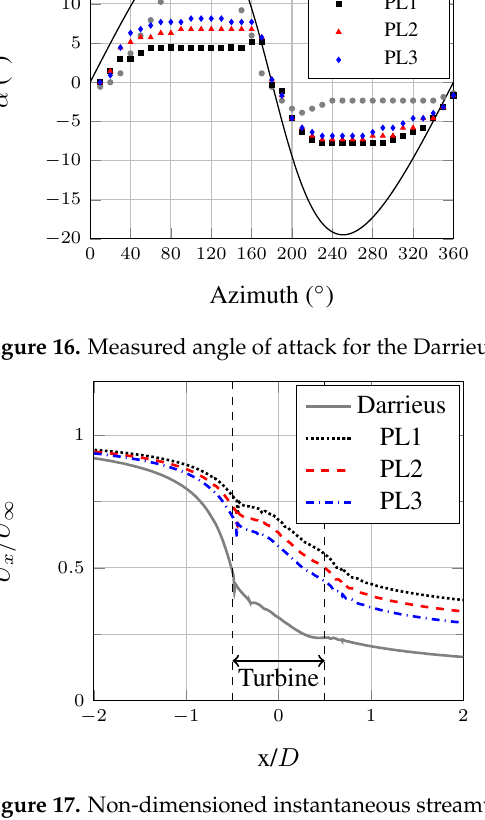
Figure 17. Non-dimensioned instantaneous streamwise velocity ( U x / U ∞ ) plotted on a line crossing the center of the turbine ( y = 0 m) in the streamwise direction. Data for the Darrieus and the pitching law cases, λ =